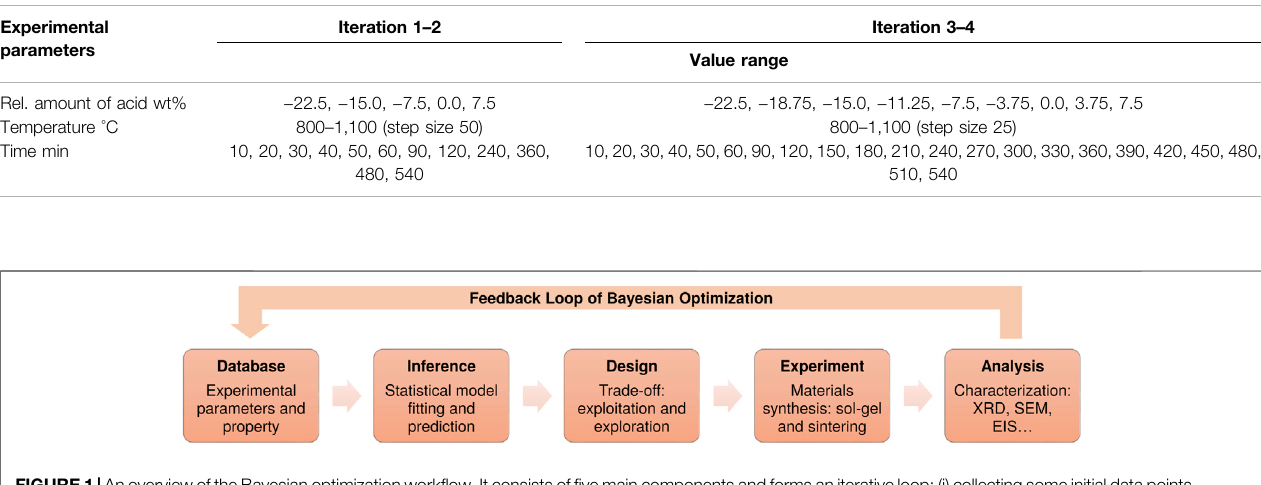
FIGURE1| AnoverviewoftheBayesianoptimizationwork fl ow.Itconsistsof fi vemaincomponentsandformsaniterativeloop:(i)collectingsomeinitialdatapoints (input-outputpairs)fromexperimentsandaggregatingthemintoadatabasewhichwillbeusedfortrainingthemachinelearningmodel;(ii) fi ttinganinferencemodel(e.g., aGaussianprocessregressionmodel);basedontheexistingdataset;(iii)predictingthepropertyinthesearchspacealongwithuncertainty,takingbothprediction(ofthe best known so far) and uncertainty (i.e., exploitation vs. exploration) into consideration for selecting the next optimal experimental con fi guration which has the potential to yield a better property; (iv) performing the experiment to synthesize new sample and (v) validating the new sample ’ s performance using different characterization techniques. The resulting sample is fed back into the initial training data set for the next